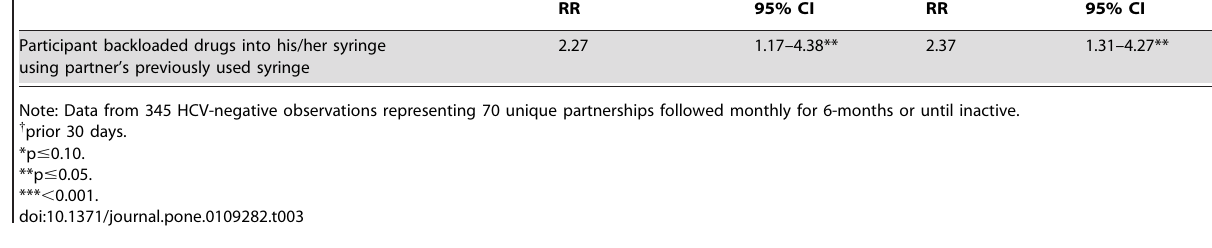
Recent Receptive Syringe Sharing (n=345)